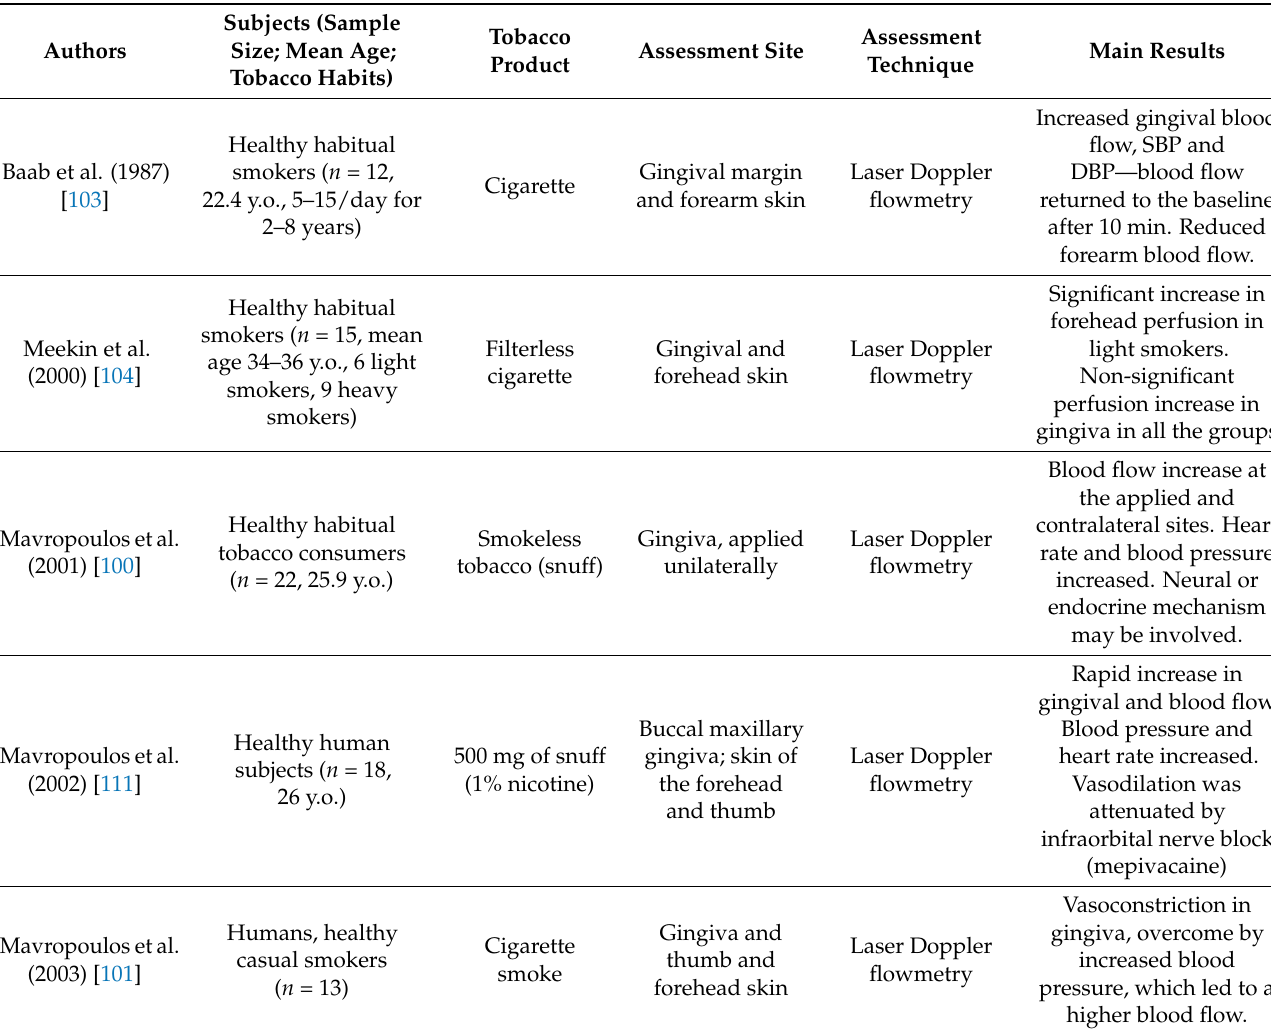
Table 2. Description of the main results of the most relevant studies into the acute effects of tobacco products on